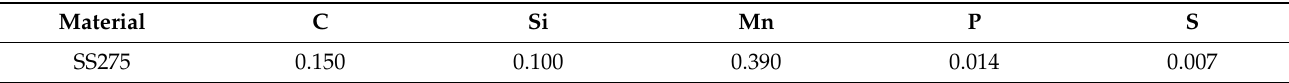
Table 4. Chemical composition of the SS275 steel (Unit: wt%).